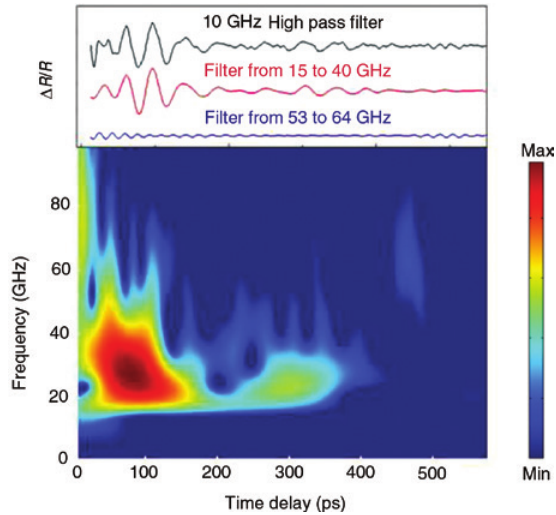
Figure 16: Top: Transient reflectivity obtained with a 360 nm pump and 720 nm probe wavelengths on a 5 periods GaN/AlN nanowire superlattices with a 56 nm GaN thickness and 42 nm AlN thickness, on top of a 900 nm long GaN nanowire with a diameter of 75 nm. with the envelope of the acoustic pulse filtered out (black curve), with a filter centered at 25 GHz (blue curve) and a filter at 60 GHz (red curve). Bottom: Time frequency analysis of the transient reflectivity with the envelope filtered out. The figure displays the amplitude of the signal at a given frequency and time. Reprinted with permission from [23]. Copyright (2013) American Chemical